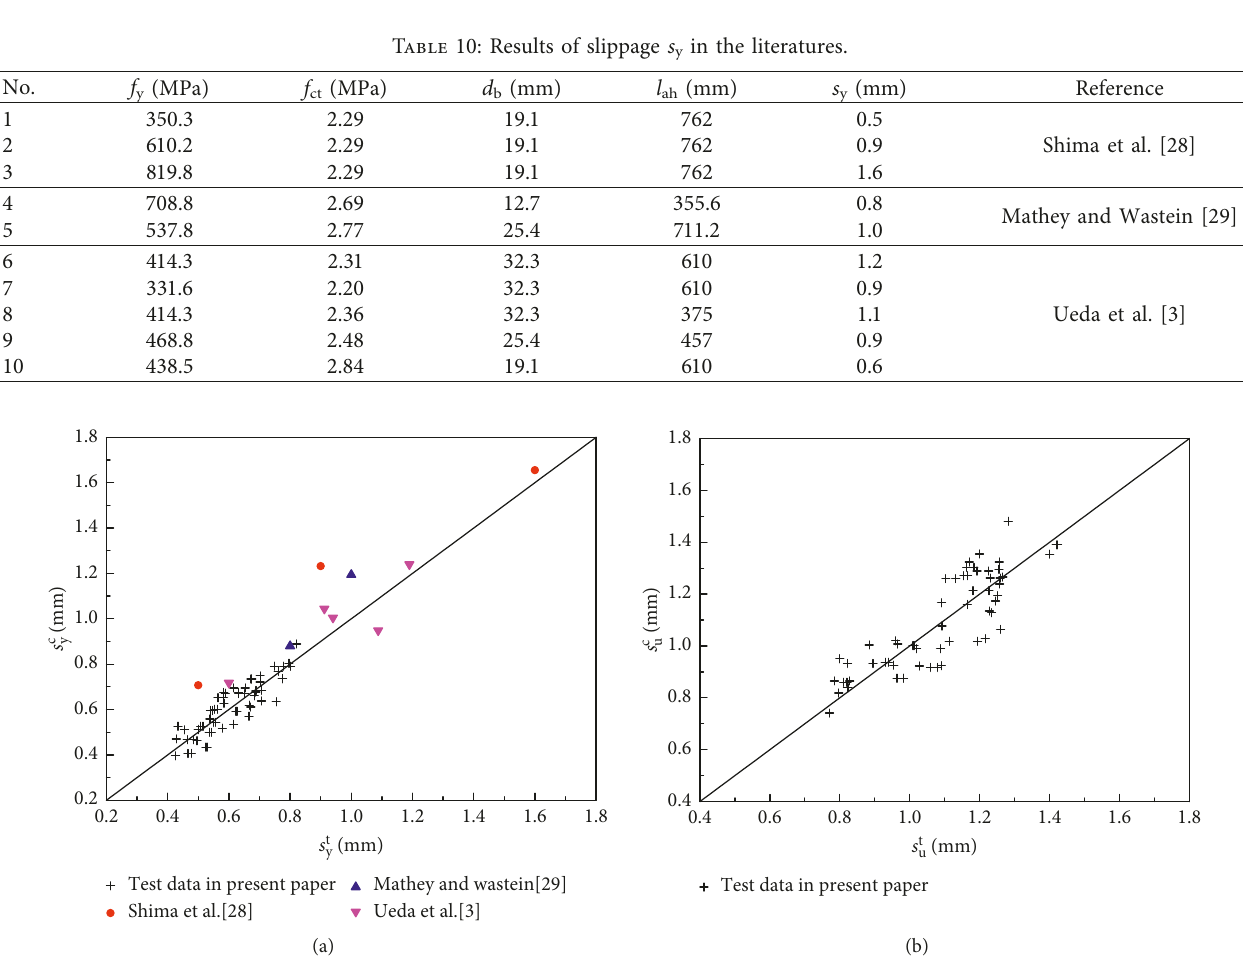
Figure 22: Comparison between calculation and experiment results of (a) s